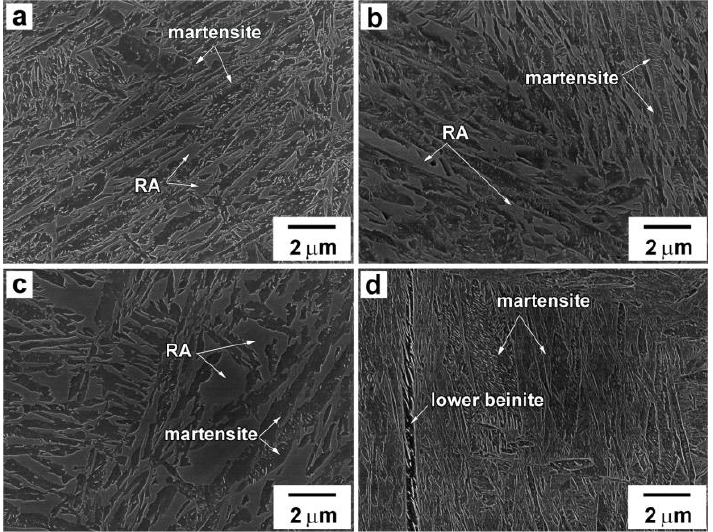
Figure 4. SEM micrographs of the Fe - 0.44C steel after quenching at 140 °C ( a ), 160 °C ( b ), 250 °C ( c ), 300 °C ( d ).